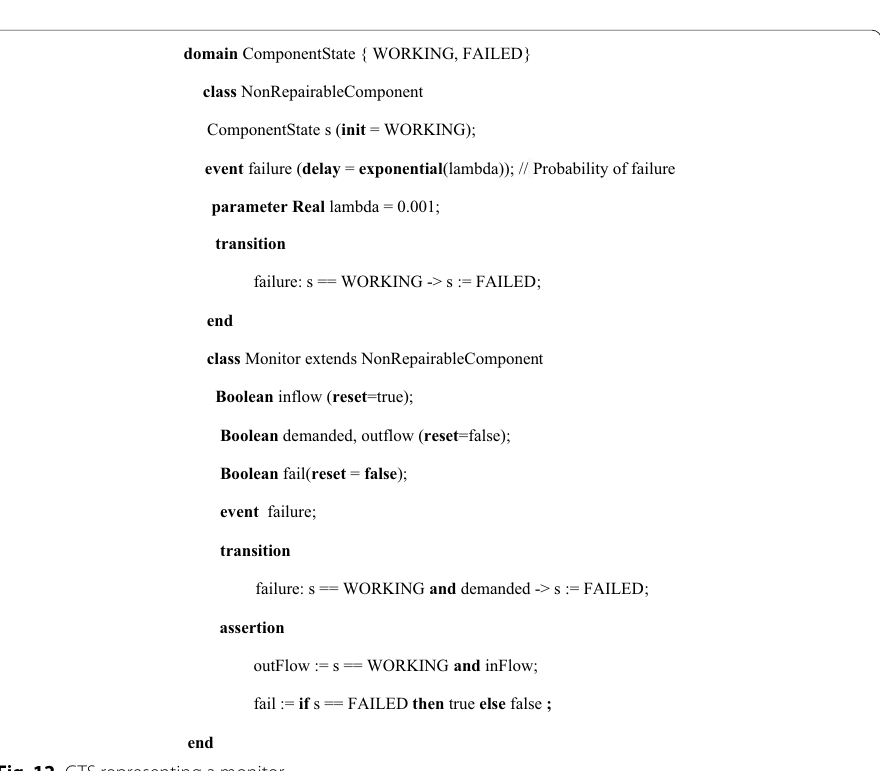
Fig. 12 GTS representing a